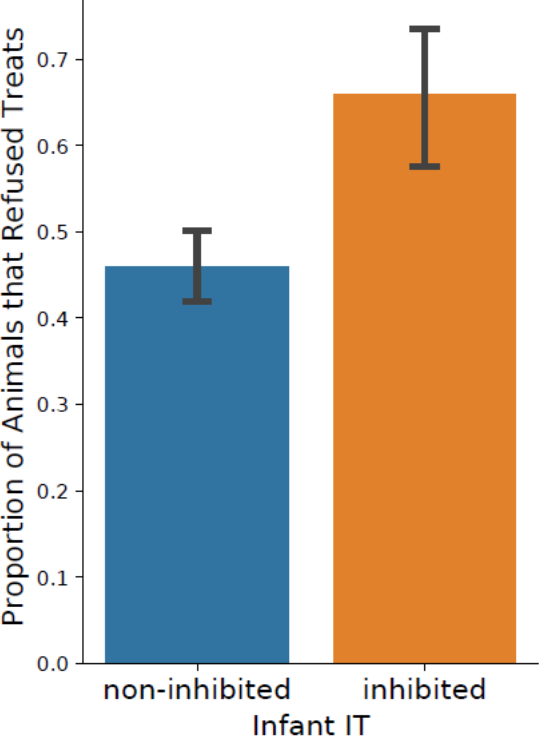
Figure 3. Behavioral inhibition and food retrieval. Behaviorally inhibited animals, identified years earlier during the BBA Program, are significantly more likely to refuse a treat compared to non- inhibited animals. Reprinted from [14].